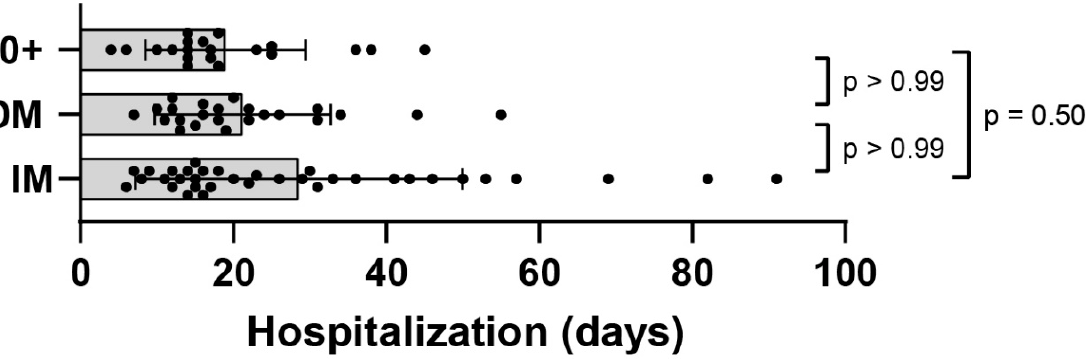
Figure 8. Duration of hospitalization of elderly (60+), immunocompromised (IM) and diabetes melli- tus (DM) patients. Days in hospital for a cohort of 78 patients. Each dot ( ) represents one patient. Brown–Forsythe test and Welch ANOVA were used as statistical tests. Statistical significance was set at p ≤ 0.05.